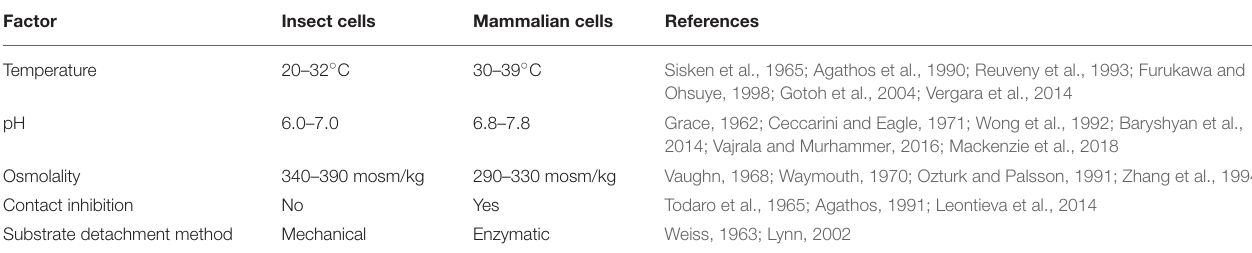
TABLE 1 | Comparison of insect and mammalian cell growth conditions and methods of